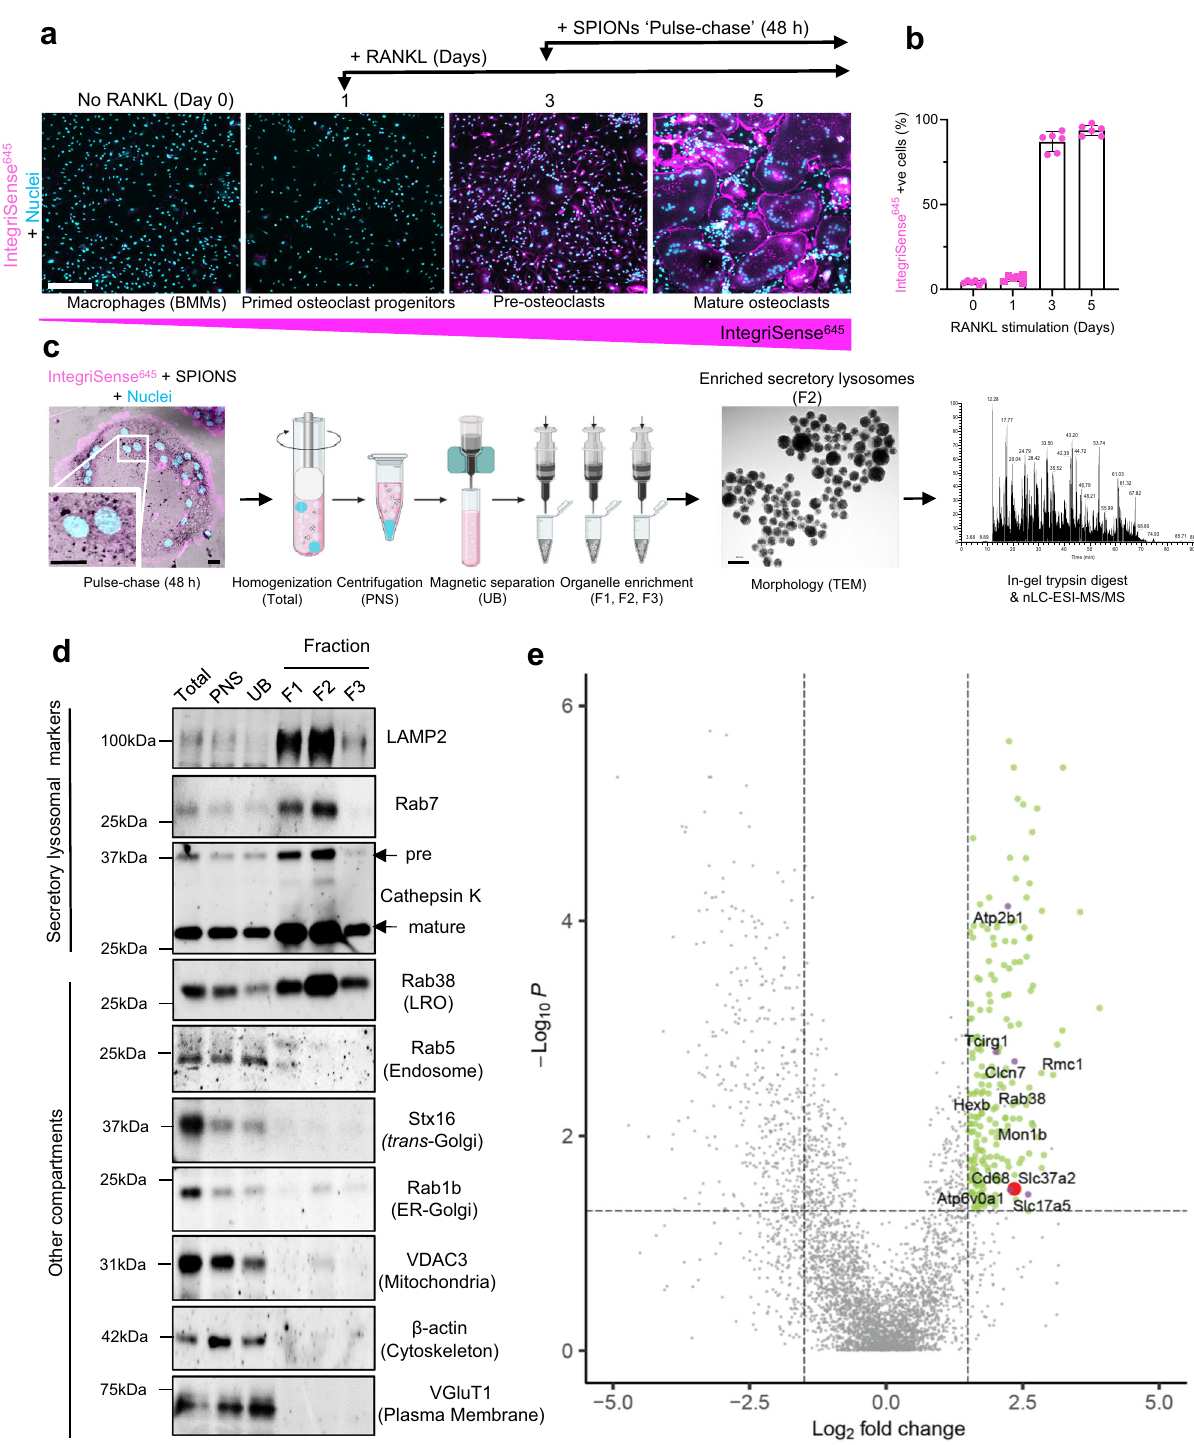
Fig.1|Proteomicanalysisofenrichedosteoclastsecretorylysosomesidenti fi es Slc37a2. a Experimentalsetup forSPION ‘ pulse-chase ’ and representative confocal imagesofmousebonemarrowmonocyte(BMMs)differentiationintomature α v β 3 - integrin-positive (IntegriSense 645 ) osteoclasts following RANKL stimulation. Bar 150 µ m. b Quantitation of IntegriSense 645 positive cells during RANKL stimulation ( n =3 biologically independent cells from 2 experiments). Data are presented as mean percentage (%)±SD. c Schema of the SPION-based SL enrichment method, validation, and proteomic analysis. Created with BioRender.com.